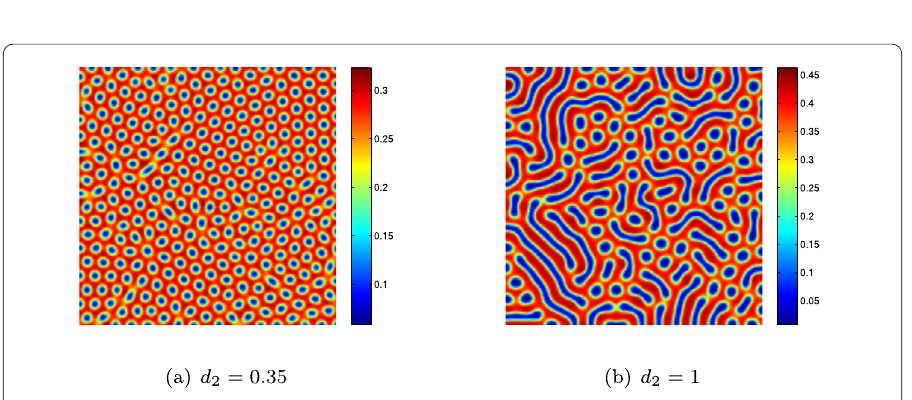
Figure 2 Turing pattern with different values of d 2 . ( a ) Cold spots pattern with d 2 = 0.35; ( b ) spot-stripe pattern with d 2 =